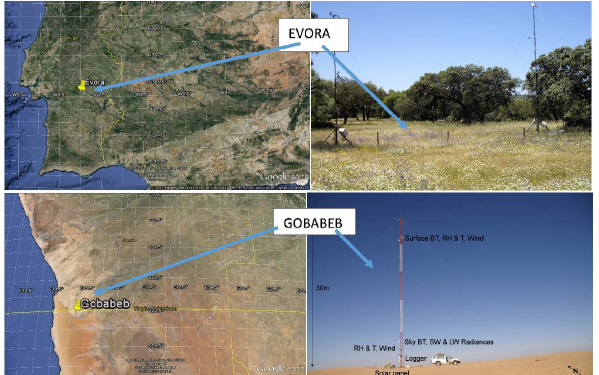
Figure 2. Evora (Portugal) and Gobabeb (Namibia) validation sta- tions. The geographic location is shown on the left, and the land- scape around the validation stations is shown on the right.